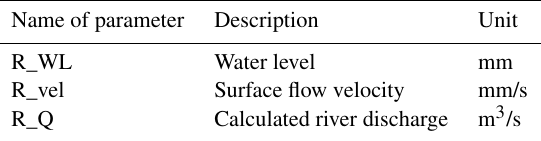
Table 7. List of river discharge parameters. Name of parameter